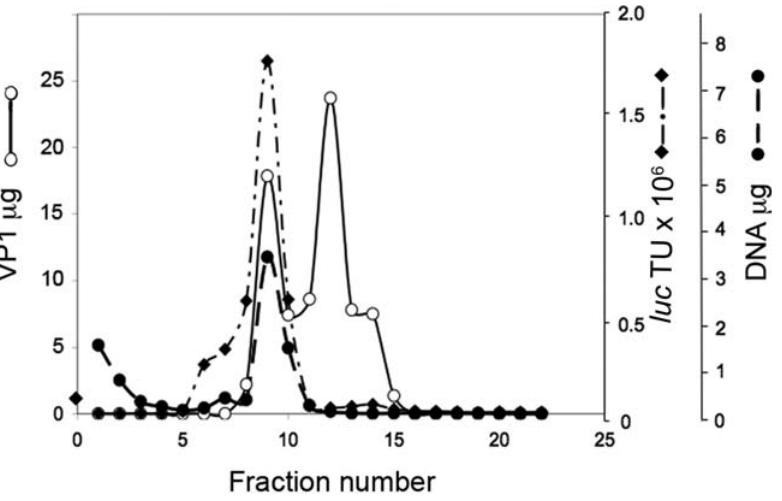
Figure 4. Equilibrium sedimentation in CsCl gradient. The reaction products, 2 ml, were fractionated on a CsCl density gradient in stabilization buffer at pH 5.2 (Materials and Methods). VP1 was analyzed by Coomassie and Bradford, DNA by real-time quantitative PCR and luc TU as described in